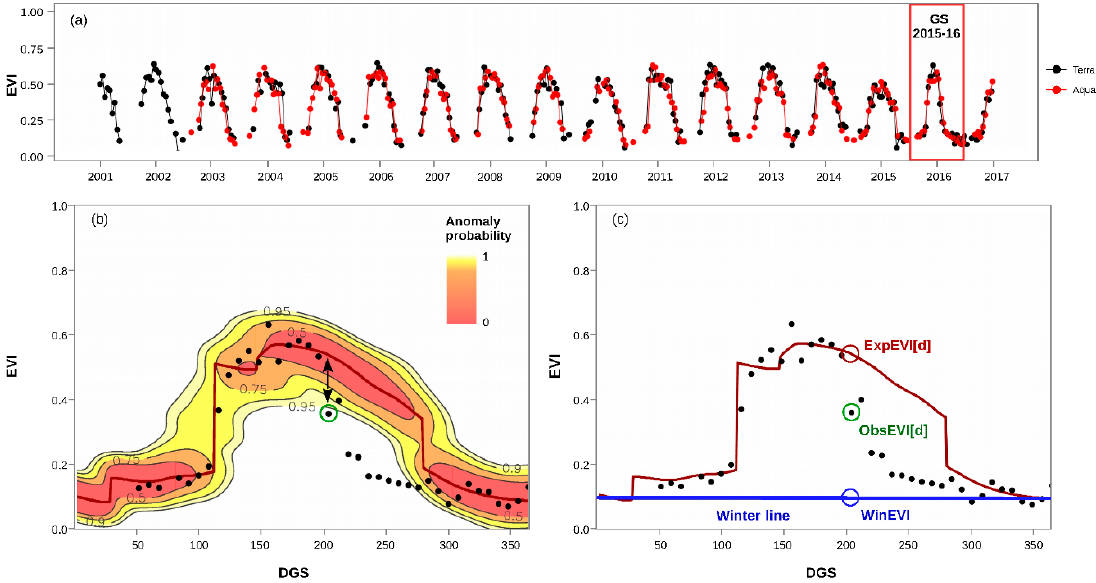
Figure 3. Calculation of EVI loss percentage using a probabilistic non-parametric approach and MODIS time series. ( a ) A dense time series of MODIS EVI Terra and Aqua combined (8-day time step) of a broad-leaved Nothofagus pumilio forest. ( b ) Kernel density estimation (time-EVI space) showing expected EVI values at different probabilities; the most probable EVI value or expected EVI per DGS corresponds to the red line; black dots correspond to the 2015–2016 GS when the outbreak took place. ( c ) Self-calibrated EVI loss calculation is achieved by calculating the Winter EVI as the minimum ExpEVI of the growing season (blue line), the EVI growth per time step, (ExpEVI[d] − WinEVI), and the observed EVI anomaly (ExpEVI[d] − ObsEVI[d]). Finally, the % of EVI loss is calculated as